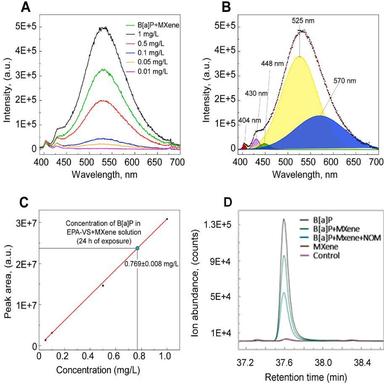
UV–Vis investigation of the adsorption of BP by MXenes. (A) Typical UV–Vis spectra of BP at different concentrations in EPA VS medium without MXenes, and spectra of BP at a concentration of 1 mg/L in EPA VS medium containing MXenes (10 mg/L). (B) Deconvolution of the UV–Vis spectra of BP. (C) Calibration curve generated using the change in area of the characteristic 525 nm peak of BP over the change in concentration of BP in EPA VS medium. The calculated concentration of BP in the MXene-containing medium af